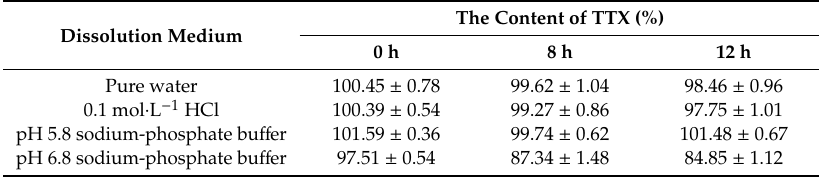
Table 1. Stability of tetrodotoxin (TTX) in dissolution mediums (mean ± SD, n = 3).